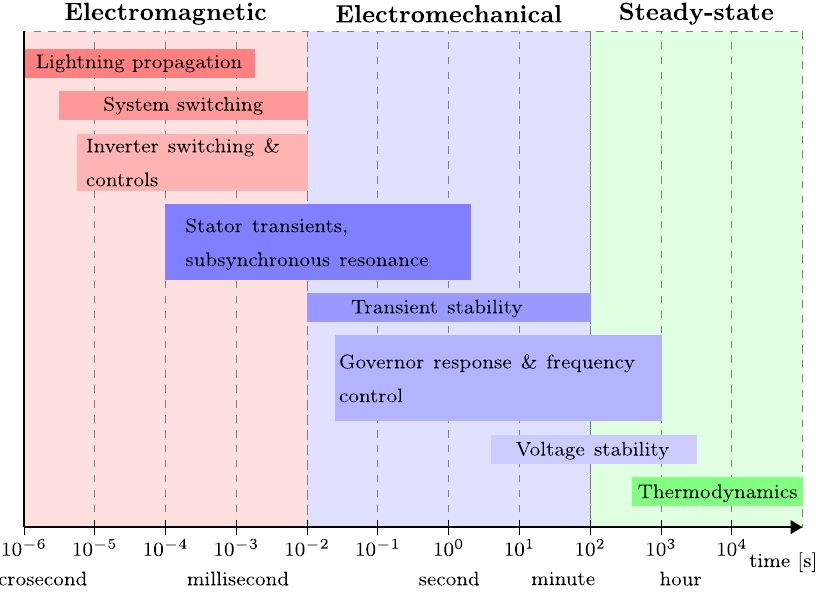
ff ering power system dynamics in electromagnetic and electromechanical Figure 1. Differing power system dynamics in electromagnetic and electromechanical timescales. Figure 1. Di